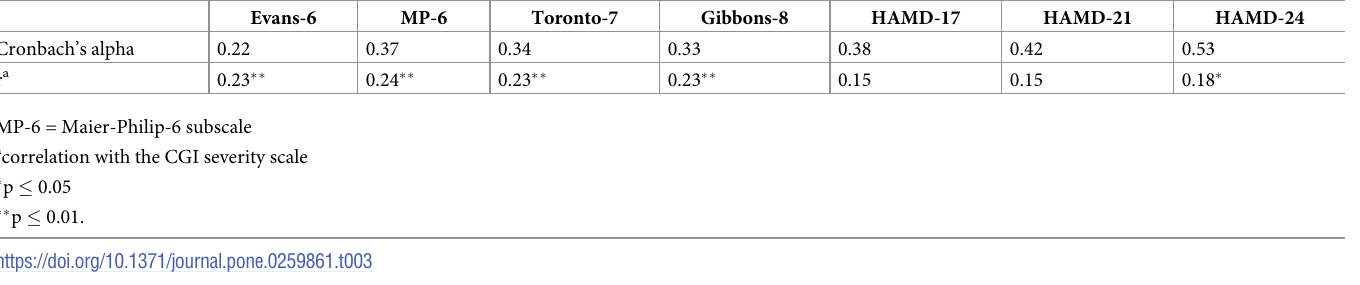
meaning the subset scales were all highly related with one another, suggesting they measure the same construct (S2 Table).